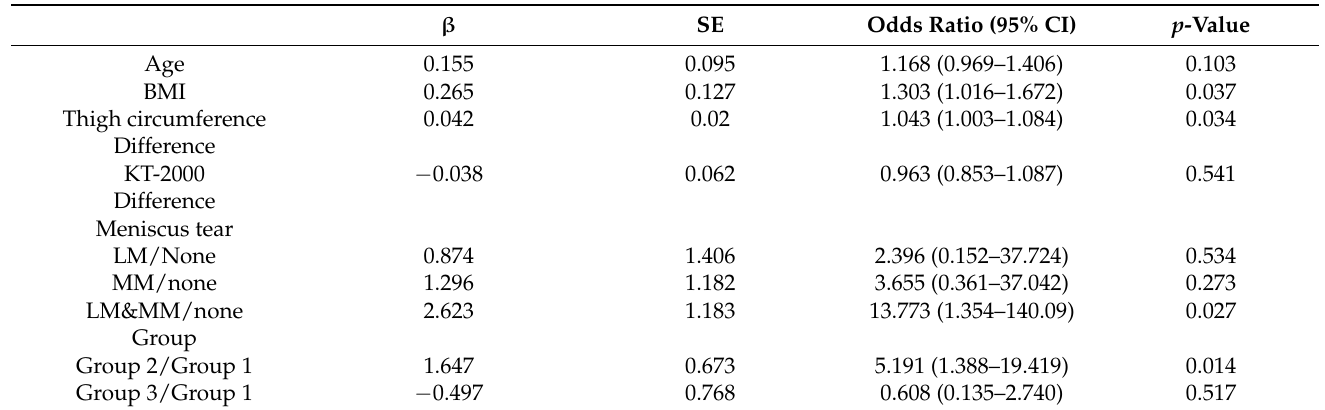
Table 3. Logistic regression analysis for cartilage